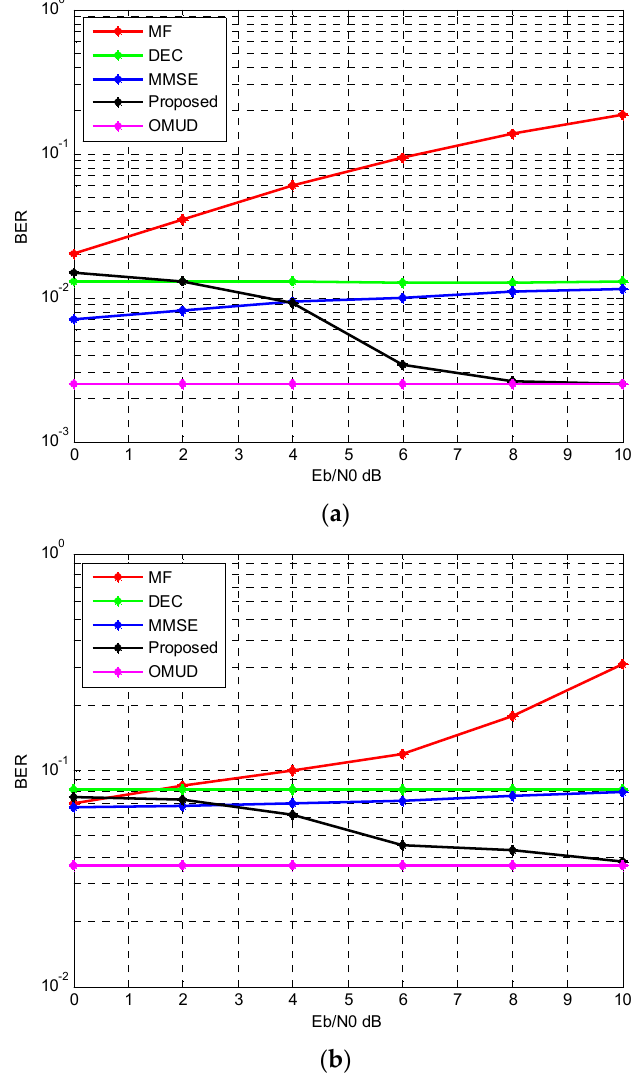
Figure 7. The near-far effect resistance performance (50 users). ( a ) AWGN; ( b ) IEEE 802.15.4a CM1.